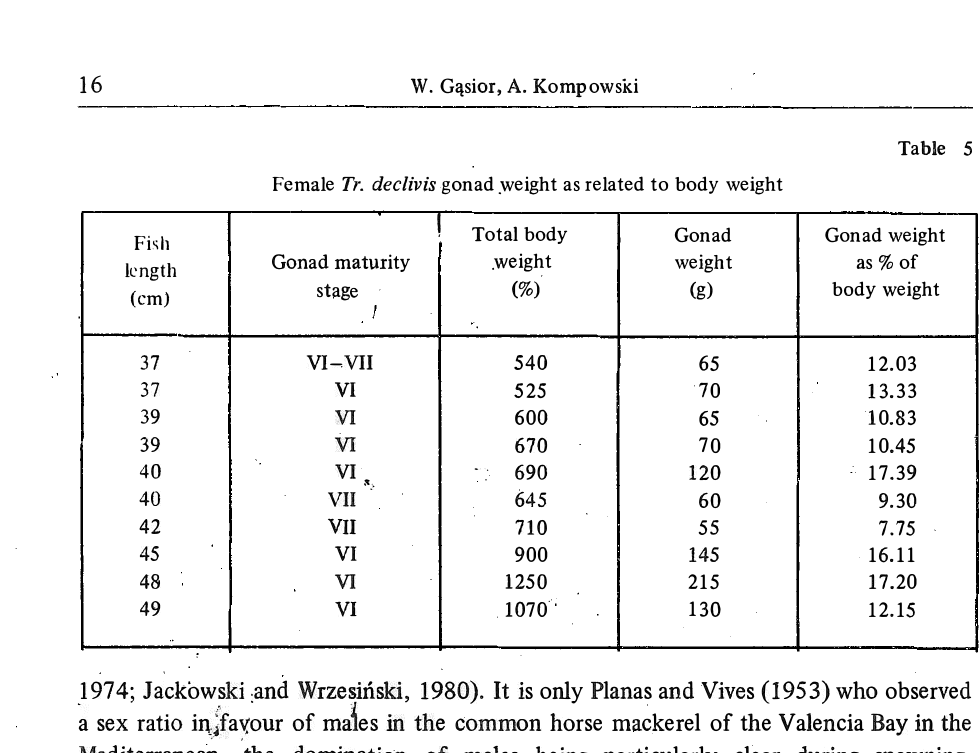
to Alejev's observations on spawing of Tr. medi­ terraneus in. the· Black Sea: a spawning concentration was found to be stratified, males gathering in the upper part and females in the lower one. All our hauls were demersal. Should the Tr. d�clivis spawning concentrations be structured similarly to those of Tr. mediterraneus, the catches would have to be dominated by females rather than by males. The explanation of the problem requires further